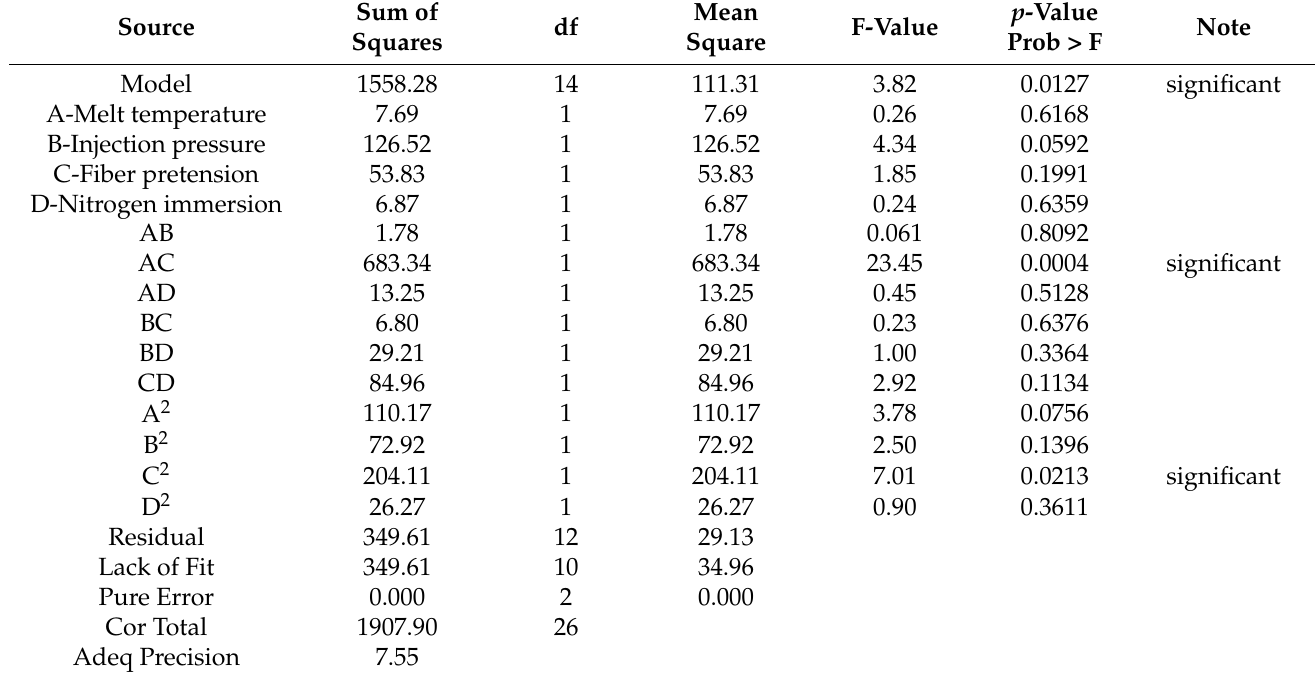
Table 7. ANOVA for impact